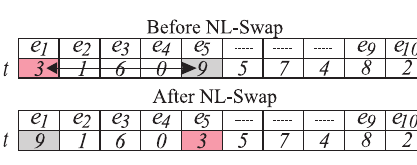
Figure 2. NL-Swap Example.